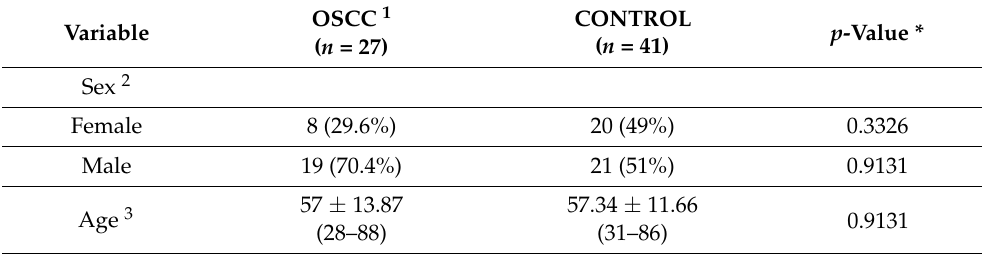
Table 1. Demographic data of patients.